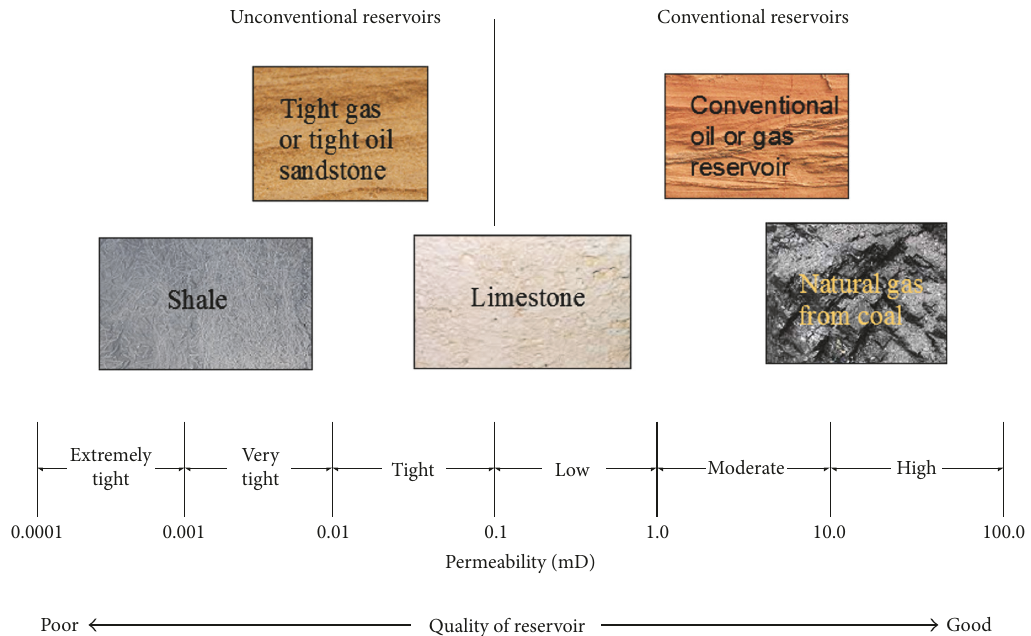
Figure 4: The classifications of oil and gas reservoirs as conventional and unconventional may be dependent on the permeability contrast. In formations where the permeability of host rock is quite small, unconventional technologies are required to increase productivity, which are otherwise uneconomical using conventional